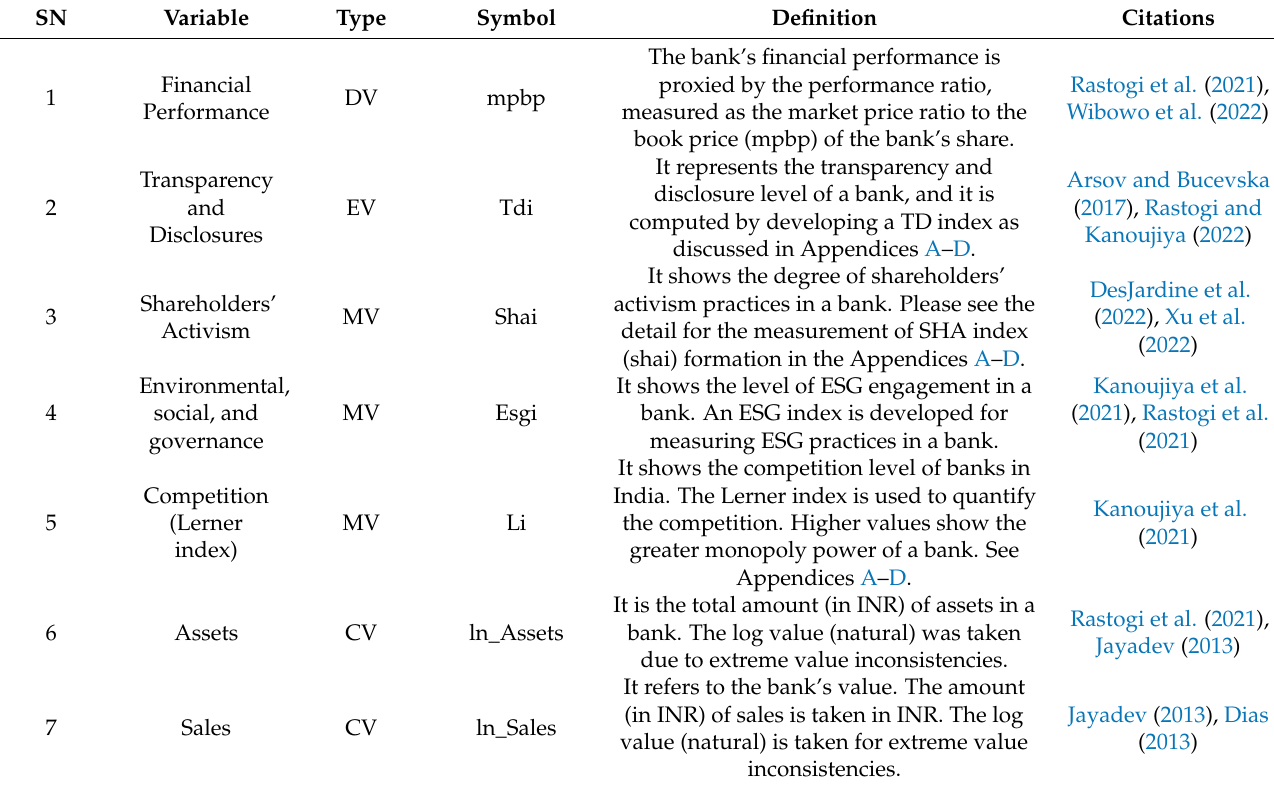
Table 1. List of